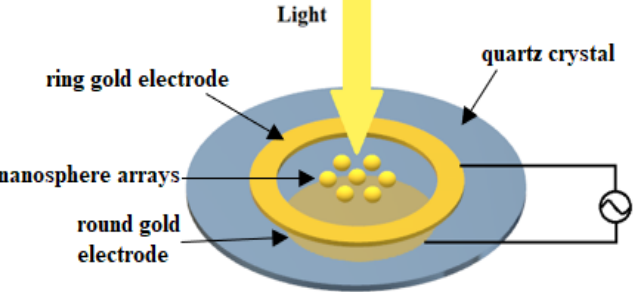
Figure 1. Structure of quartz crystal microbalance (QCM)/local surface plasmon resonance (LSPR) chip.